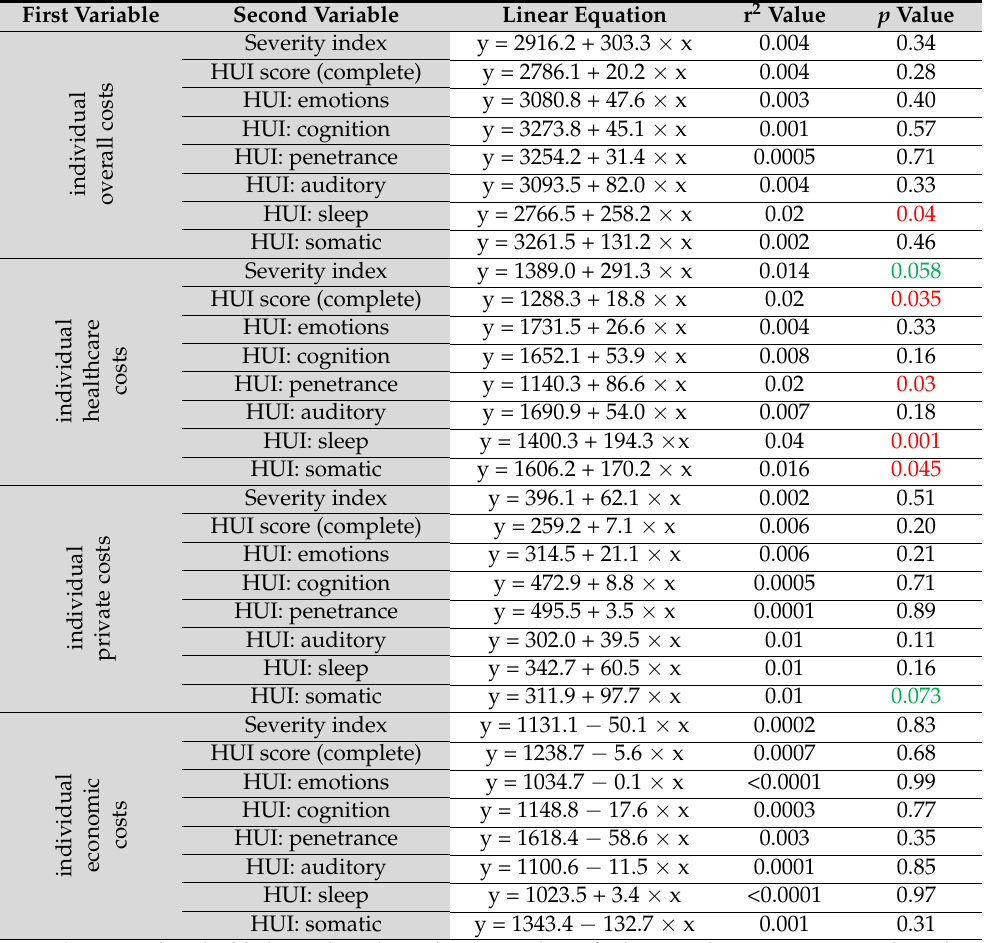
Table 5. Results of multiple linear regression analyses of severity index and HUI scores vs.